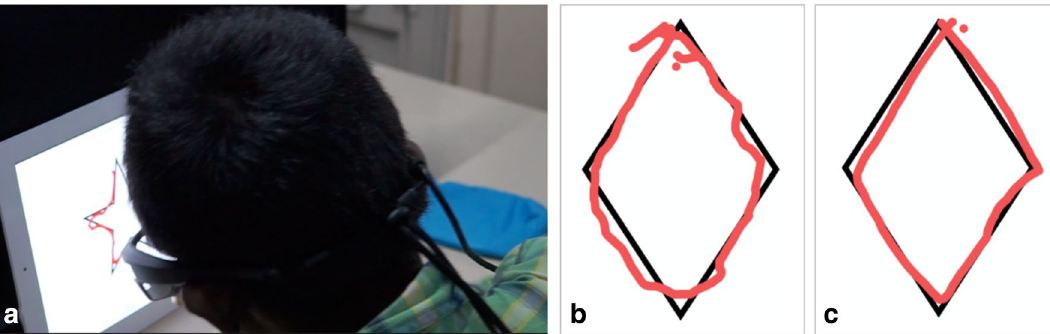
Figure 5. ( a ) A 12yo Prakash child performs a tracing task after treatment for bilateral congenital cataracts. ( b ) A sample tracing of a diamond by this child one-month post-treatment (pre-operative bilateral acuity was 20/3200, acuity at time of tracing experiment was 20/600). ( c ) Tracing by a control 10yo male with typically developing vision while wearing blur goggles that impose a 20/500 bilateral